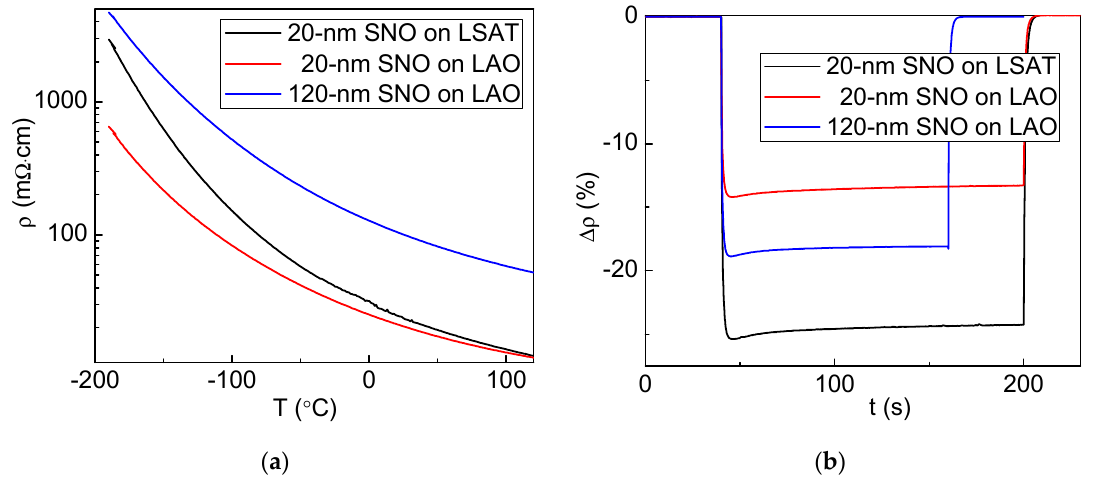
Figure A4. ( a ) Resistivity temperature dependence for other tested SNO films: two 20-nm thick films deposited on LSAT and LAO and a 120-nm thick film on LAO. ( b ) Percentage change of their room-temperature resistivity at long-term illuminations by the blue laser at optical power 0.8 W Table A1. Photoresistivity parameters for all tested films at T = 26 °C and the reference blue light illumination of 0.8 W power: percentage changes of the resistivity Δ ρ , the measured absorption factors α of the film-substrate stacks, resistivity values ρ , derivatives d ρ /dT and estimated rises of the film temperature Δ T .